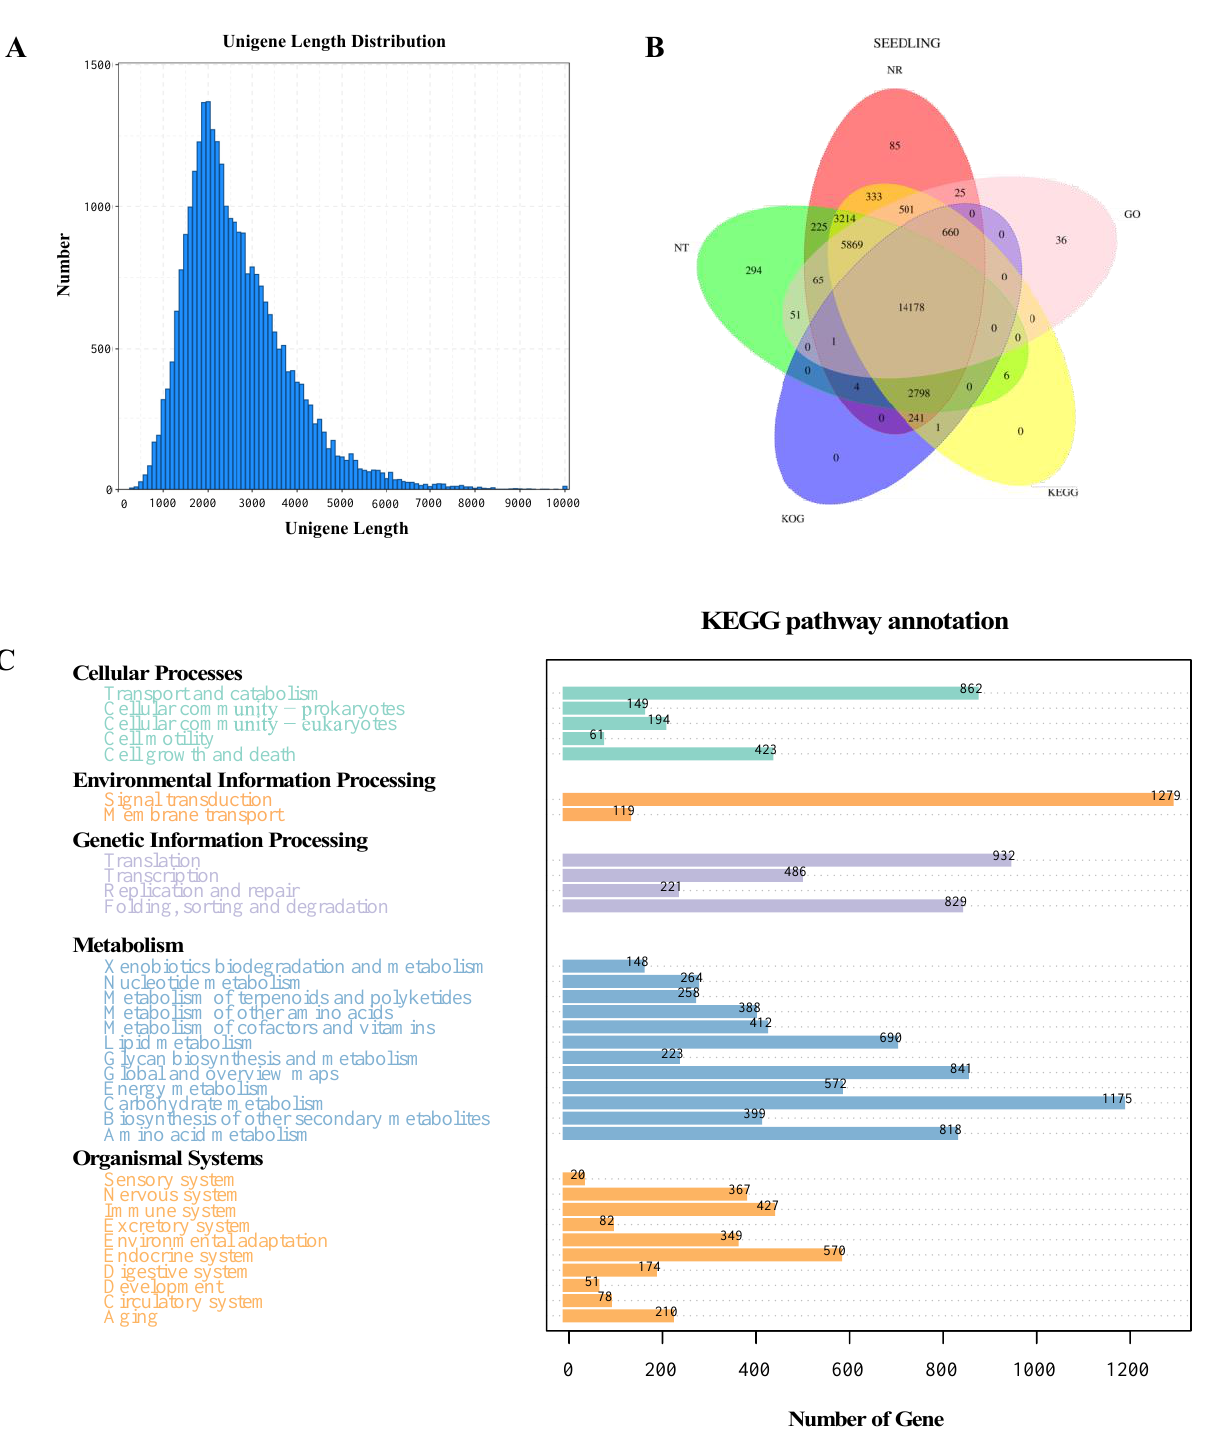
Figure 2. Annotation and classification of assembled unigenes in radicles development of A. be- shanzuensis . ( A ) Length distribution of subreads at different development stage of two-type roots (RH1_B, RH1_0, RH1_A, RH0_B, RH1_0, and RH1_A), RH1, radicles with root hair; RH0, radicles without root hair; B represents 2 days before root hair initiation; 0, root hair initiation; A represents 2 days after root hair initiation, the same meaning as below. ( B ) A total of 28,923 unigenes were totally annotated using different protein databases. ( C ) KEGG assignments for functional classification of the assembled